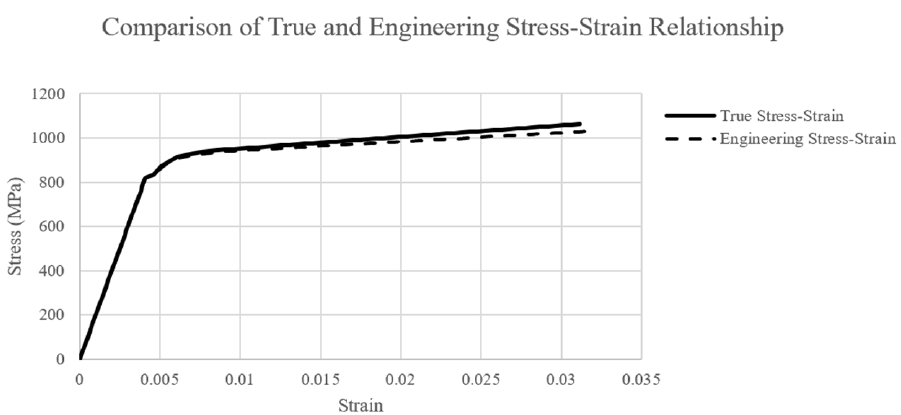
Figure 5. True vs. engineering stress–strain relationship.